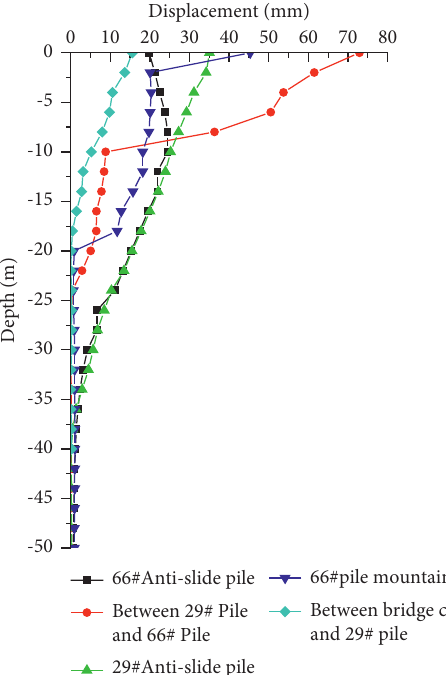
Figure 18: The displacement curve of the deep part of the slope.